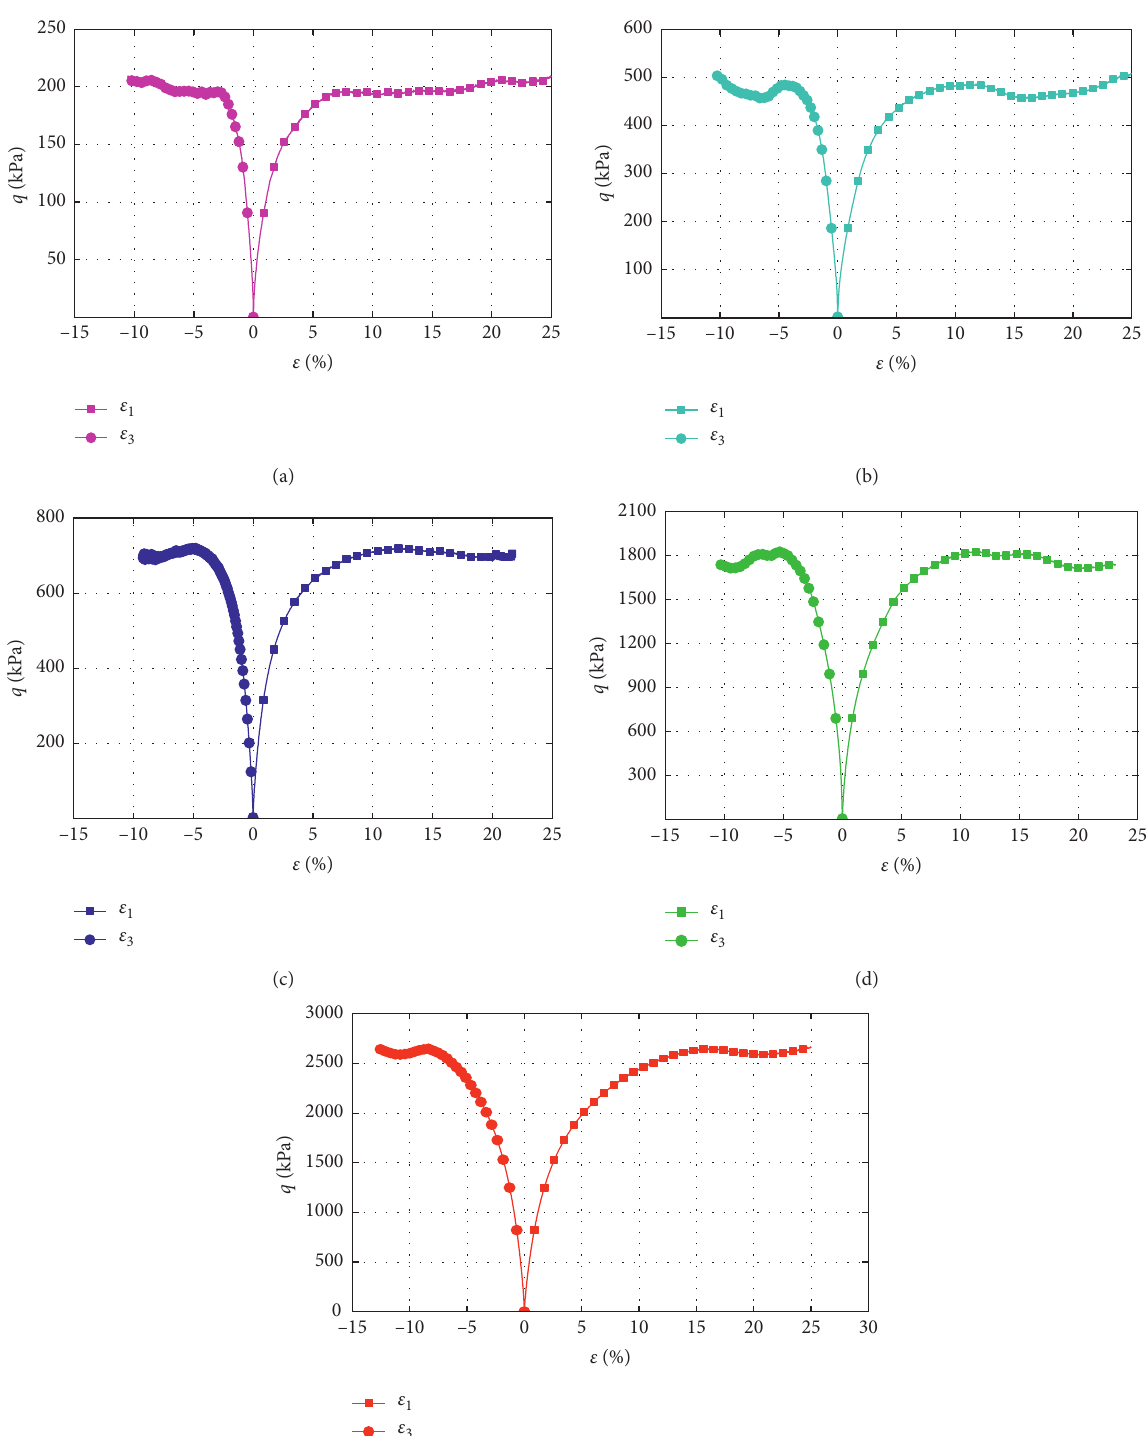
Figure 11: The relationships of q and ε at different σ